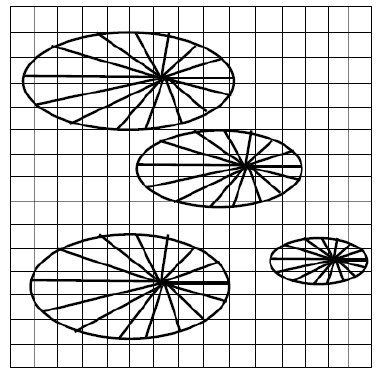
Figure 2. Schematic representation of square cells and unstructured grids: the square cells are used for Monte Carlo simulation, the unstructured grids are used for prediction the shape evolution of spherulites